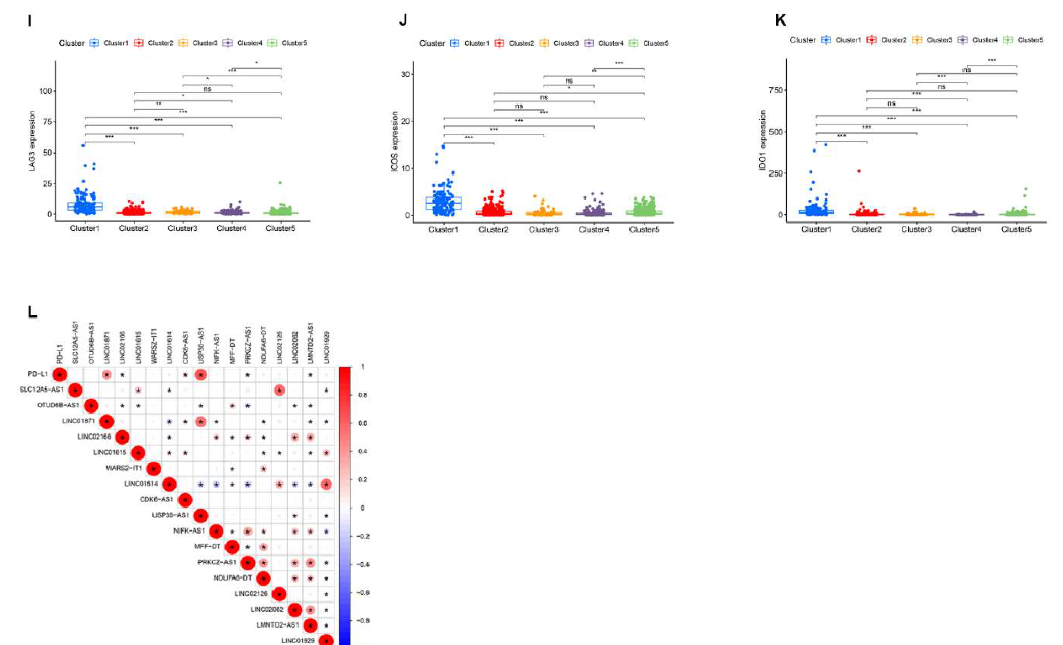
Figure 2. NMF analysis based on prognosis-related AR-lncRNAs in BC. ( A ) Consensus map for NMF clustering. ( B , C ) Kaplan–Meier curves of OS and PFS for five clusters. ( D ) Heatmap and clinicopathologic features of the five clusters. ( E – K ) Differential expression of immune checkpoints PD-L1, PD-1, CTLA-4, Tim3, LAG3, ICOS, and IDO1 in different clusters. ( L ) Correlation of PD-L1 and 17 prognostic AR-lncRNAs. (Red indicates a positive correlation, blue indicates a negative correlation, and an asterisk indicates statistical significance. The darker the color, the more obvious the significance) ns, no significance; * p < 0.05, ** p < 0.01, and ** * p < 0.001.